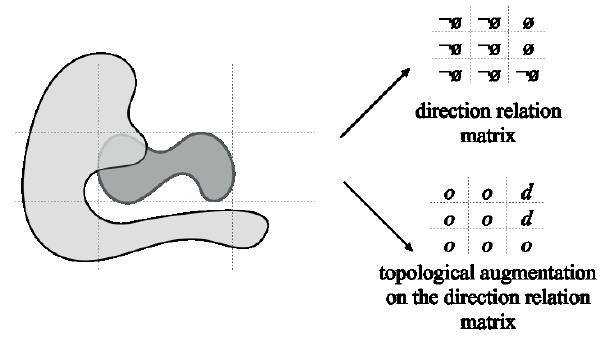
Figure 11: A comparison between the direction relation matrix of a pair of objects and the corresponding topological